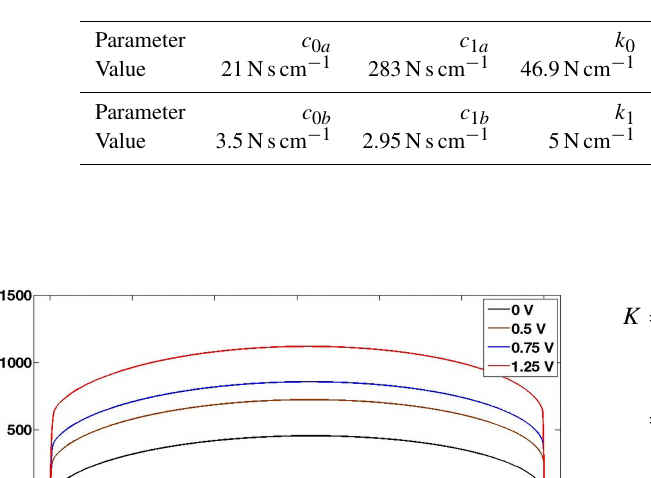
Table 1. Parameter values of the augmented Bouc–Wen model.